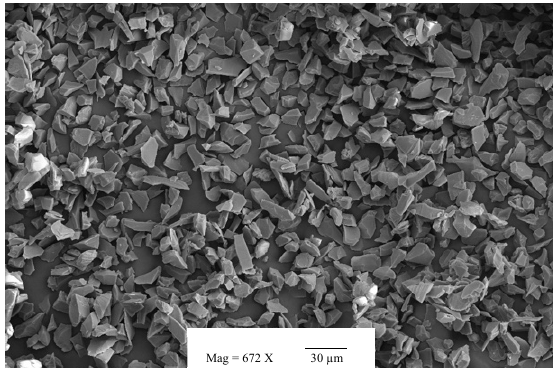
Figure 2. Secondary electron images of the as-received commercial silicon carbide particles in aggregate state.